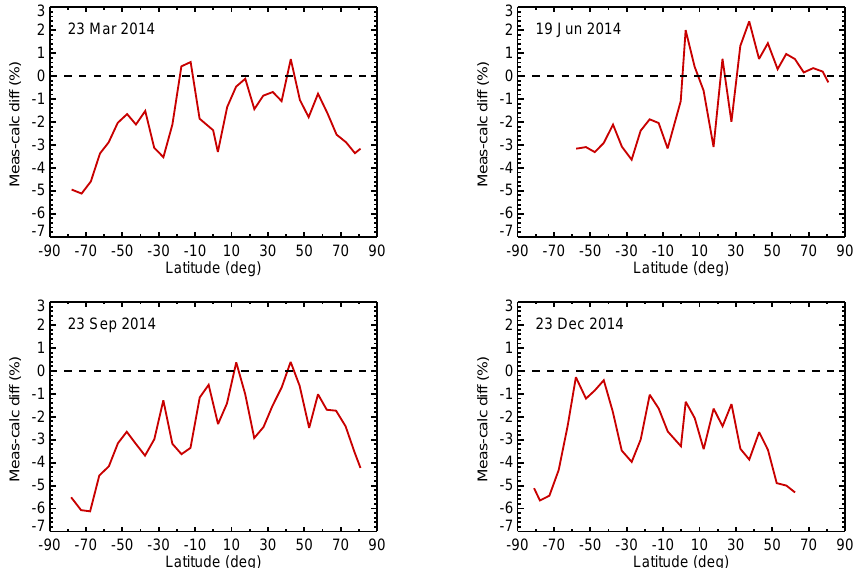
Figure 13. We have estimated the DUR modeling error by comparing 350nm measured and modeled radiances at 3hPa. The radiances are modeled using an independent, nearly simultaneous measure of surface reflectivity derived from the OMPS Nadir instrument at 340nm. The 50 × 50km nadir-view measurements are relatively insensitive to DUR effects. The radiance differences (given for the same 4 cardinal days as in Fig. 12) suggest model or calibration errors of 2–3% on average ( ± 200m), plus structure caused by the contributing limb and nadir scene mismatch.